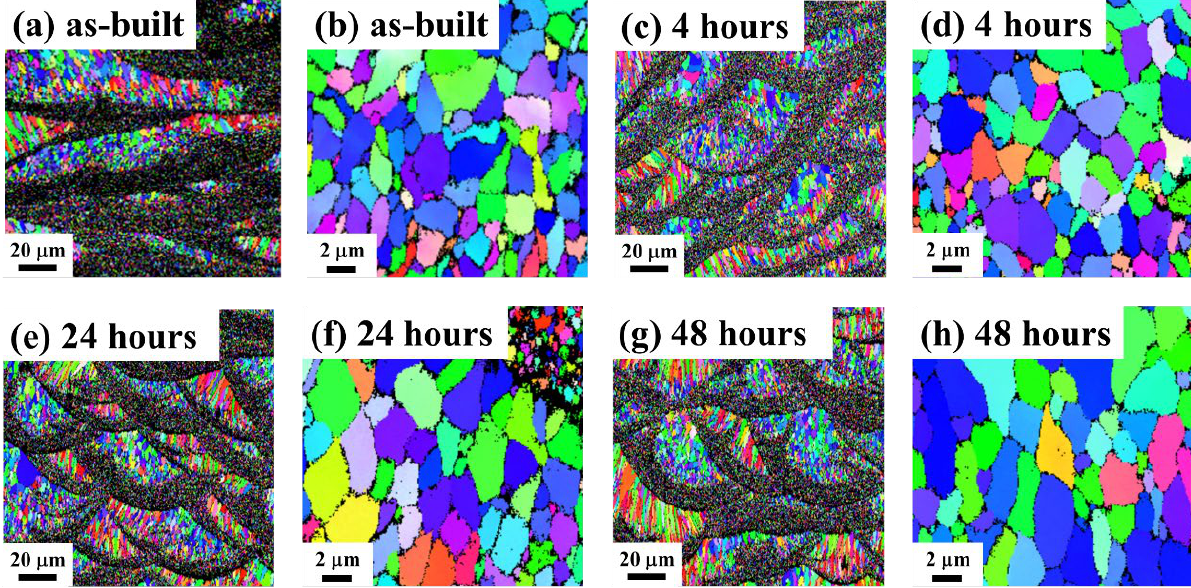
Figure 3. The EBSD images of ( a , b ) as-built sample, ( c , d ) heat-treated sample at 325 °C for 4 h, ( e , f ) sample heat-treated at 325 °C for 24 h, and ( g , h ) heat-treated sample at 325 °C for 48 h.